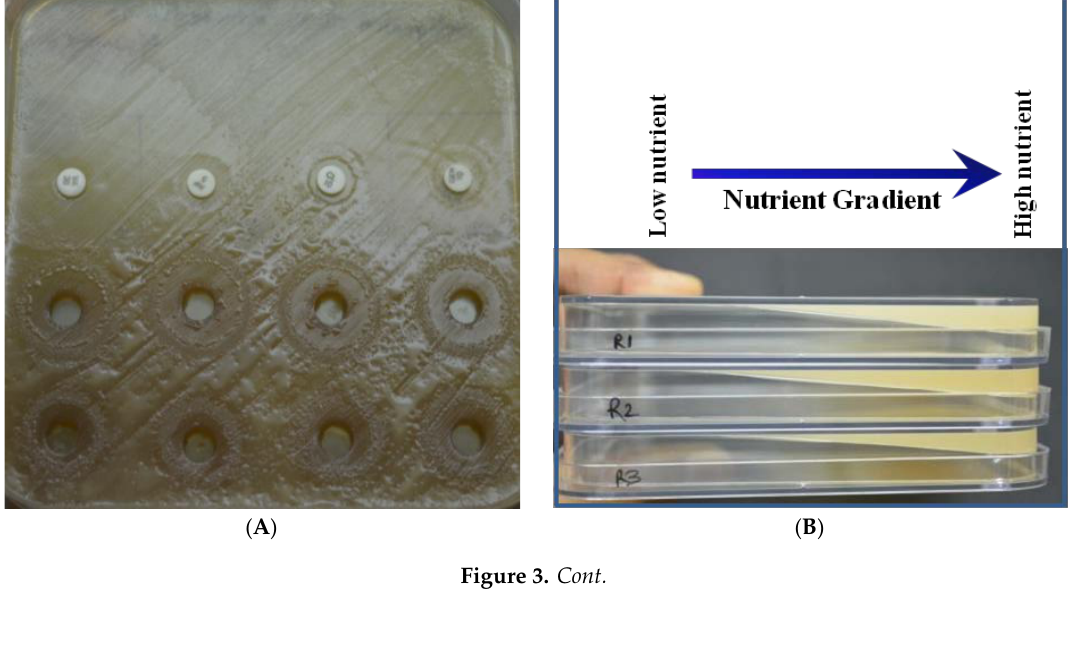
SN. Colony Morphology (before